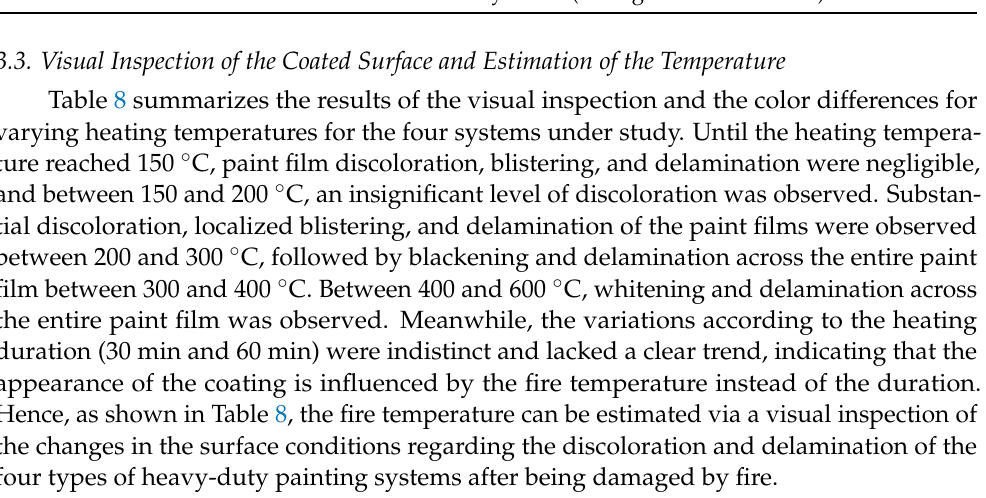
Table 8. Relationship between temperature and surface condition change of heavy-duty-paint-coated steel.